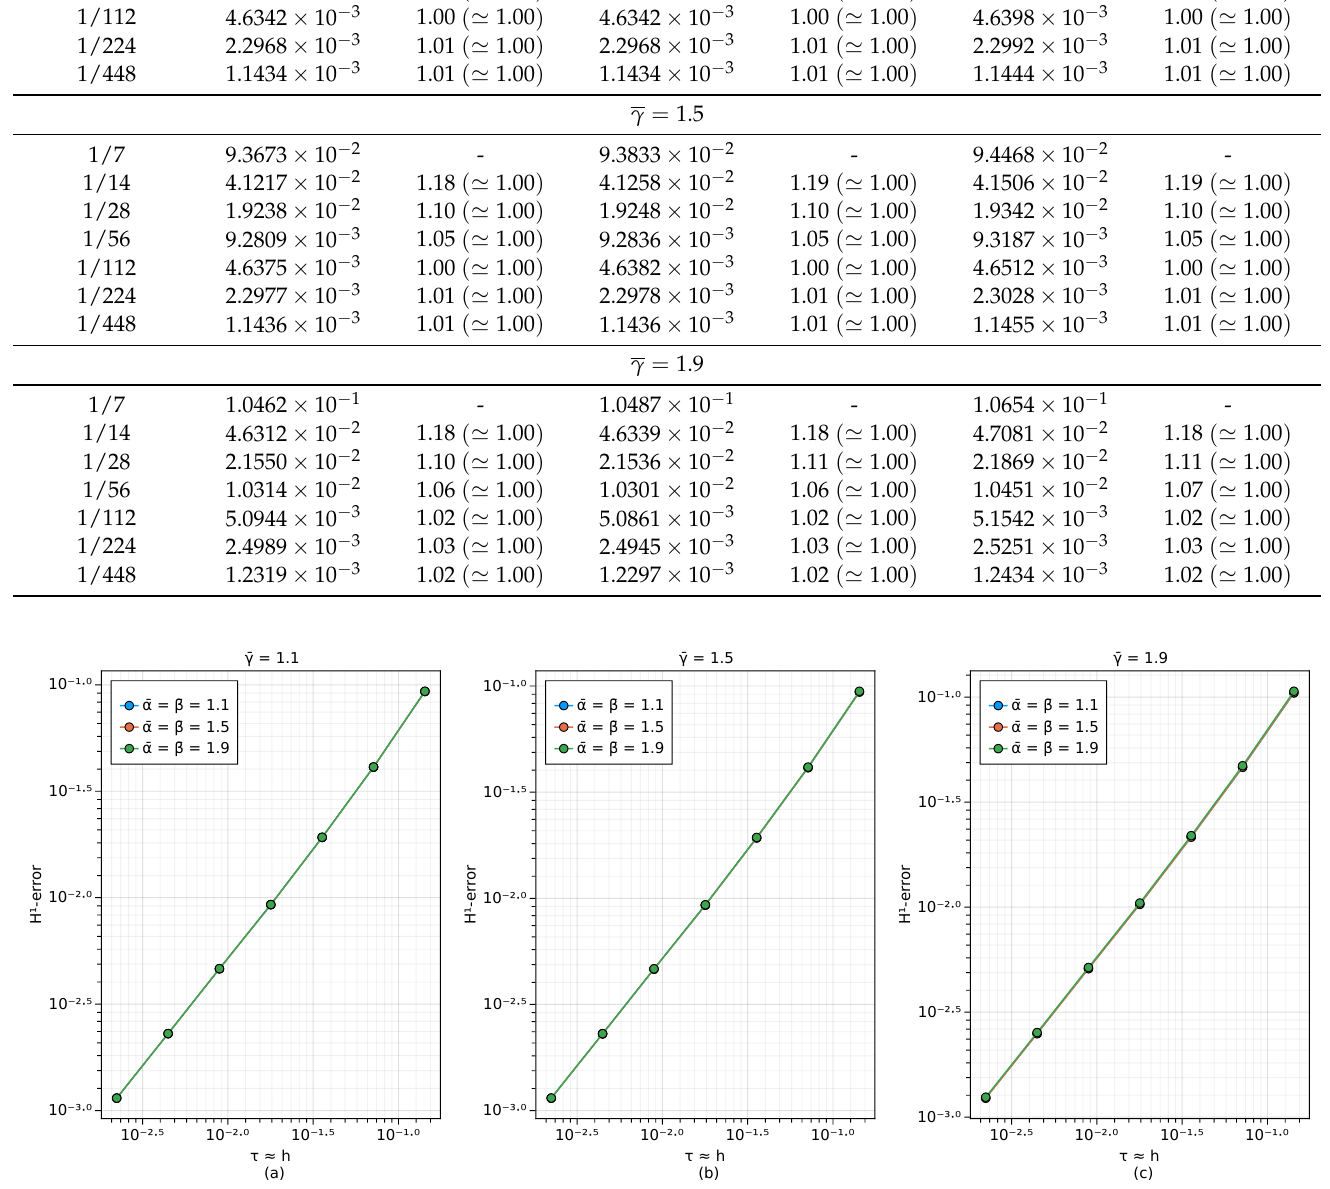
Table 2. H 1 -errors, E 2 , i ≥ 1 calculated by (55) and convergence orders, R 2 N i (56) for different values of τ i ≈ h i , N i = 1/ τ i . The numbers in parentheses indicate the theoretical convergence order.